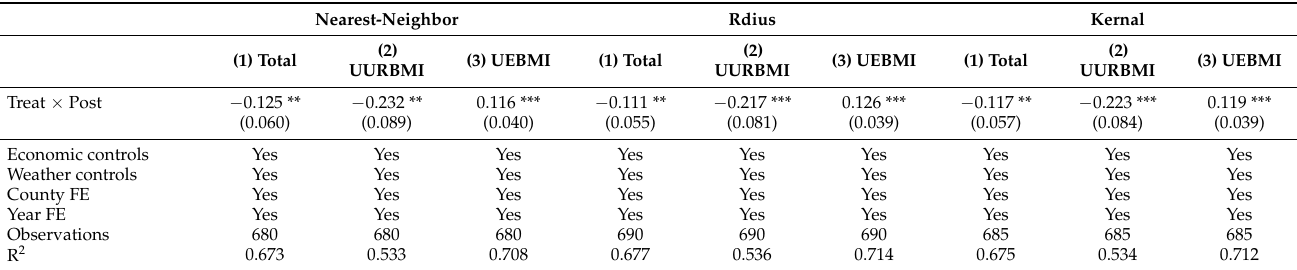
Table 4. Robustness checks: PSM-DID.